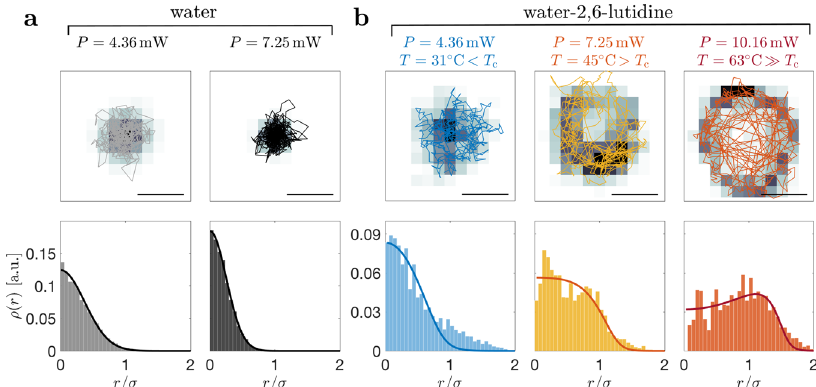
Fig. 2 Nanoparticle trajectories and probability density distributions. Trajectories (top) and probability density ρ ( r ) (bottom) for a nanoparticle with radius a = 75 nm held by an optical tweezers, a in water at powers P = 4.36 (gray), and 7.25 mW (black), and, b in a critical mixture of water-2,6-lutidine at P = 4.36 (blue), 7.25 (yellow), and 10.16 mW (orange). Sample trajectories in the xy -plane are shown for 200 ms, while the background shading indicates the counts (darker colors indicate higher counts); the scalebar is 1 μ m. The probability densities ρ ( r ) are calculated from data acquired for 1 s. a In water, the P and, therefore, the ð r Þ / exp (cid:2) V data are well described by the Boltzmann distribution ρ k B T (solid lines), which becomes narrower as the laser power eq optical trap potential depth increase. b In water-2,6-lutidine, the particle features an out-of-equilibrium distribution, which broadens with increasing laser power. Here, the solid lines are given by Eq. (5). All data are taken at environment temperature T 0 = 3 °C, i.e., ≈ 30 K below T c . Due to absorption, the particle ’ s surface temperature increases by 6 K mW − 1 such that, at P = 7.25 and 10.16 mW, T exceeds T c and the solution locally demixes. The radial distance has been normalized by the beam waist σ = 340